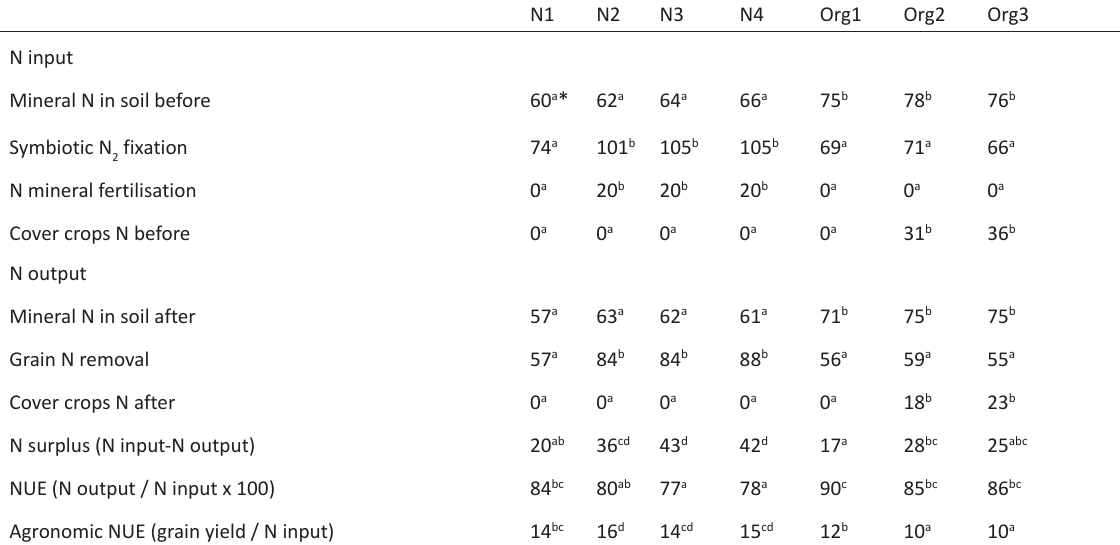
Table 5. N surplus (kg ha -1 ), nitrogen use efficiency (NUE) and agronomic NUE (kg DMY kg -1 N) of field pea as an average 2012–2016 N1